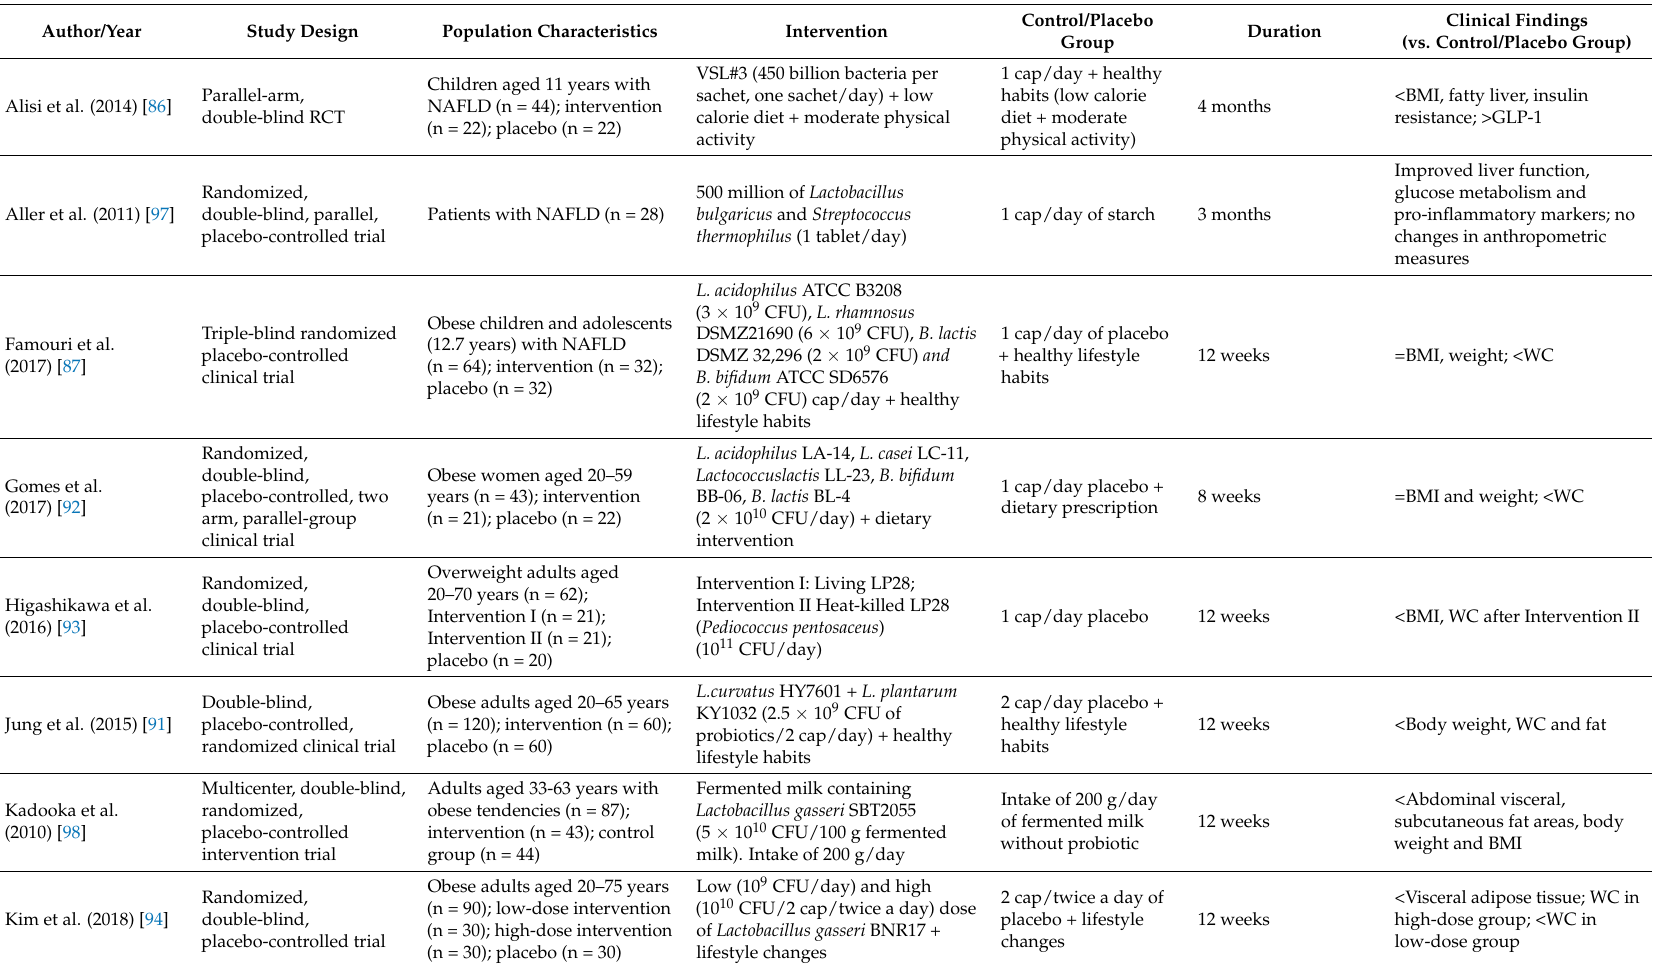
Table 1. Summary of anti-obesity effects of probiotics reported in randomized controlled clinical